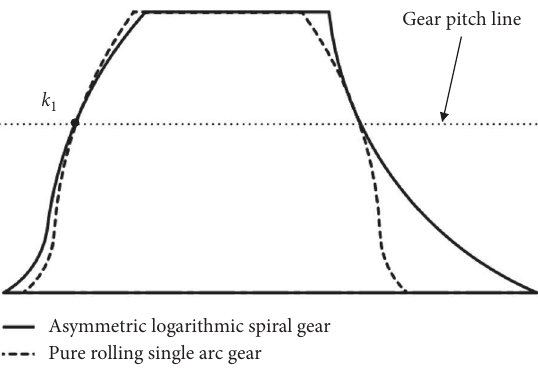
rotation angles of gears (°)